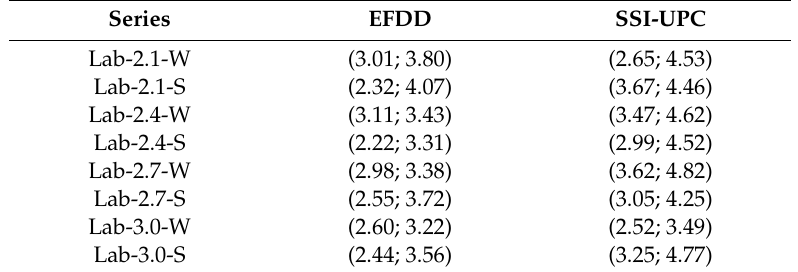
Table 6. Confidence intervals (95%) for the fundamental damping ratios (%) of laboratory